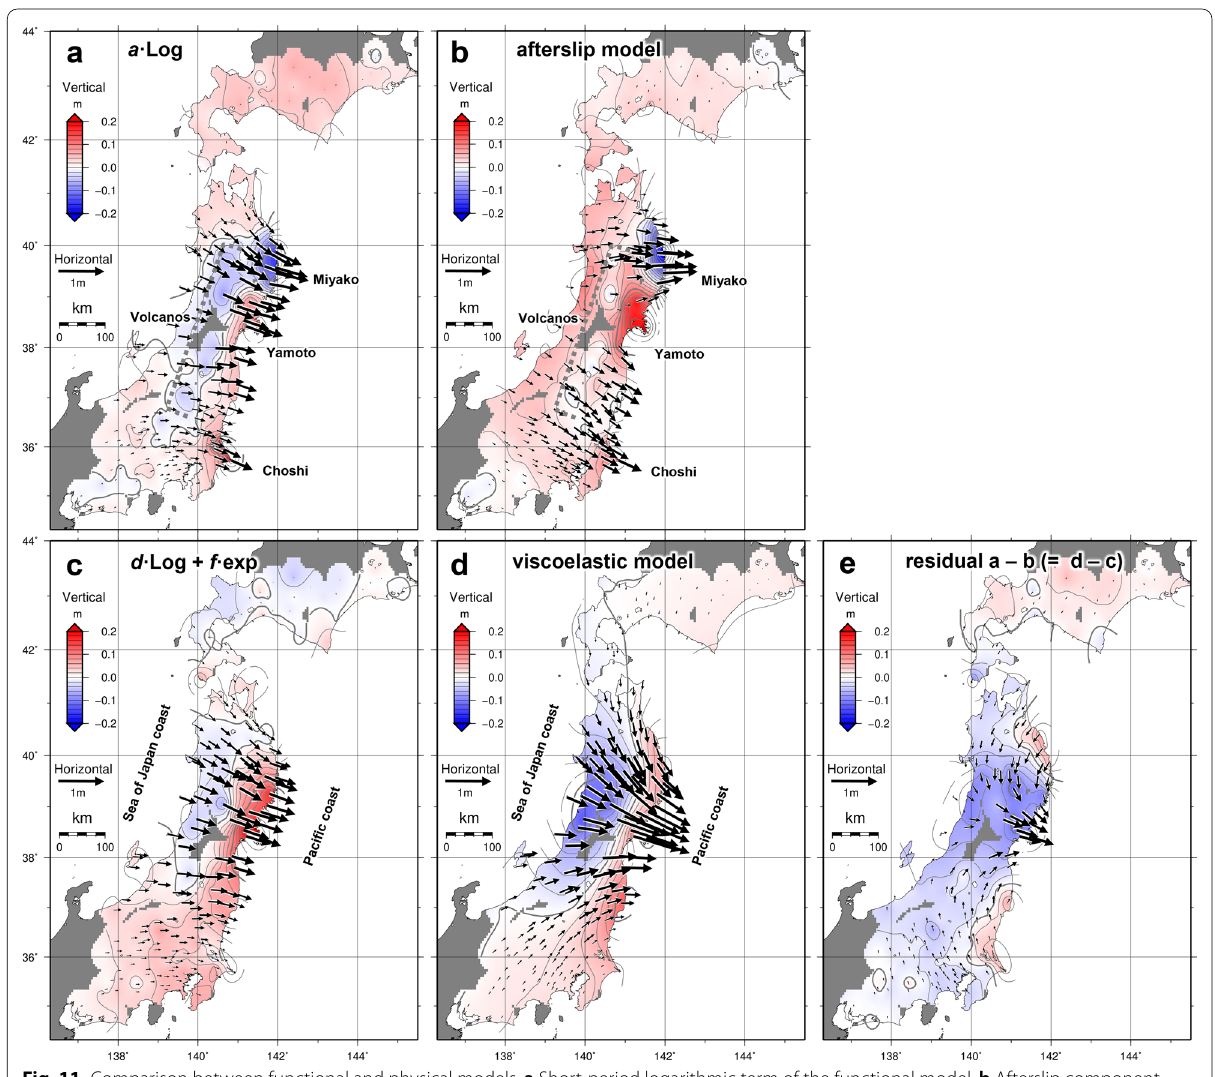
Fig. 11 Comparison between functional and physical models. a Short-period logarithmic term of the functional model. b Afterslip component based on the physical model. c Sum of the long-period logarithmic term and the exponential term of the functional model. d Viscoelastic relaxation component of the physical model. The values for each term represent three years after the earthquake (March 11, 2014), with the values immediately after the earthquake set to zero. e Residual a minus b ( d – c ). The physical model was obtained from Suito =